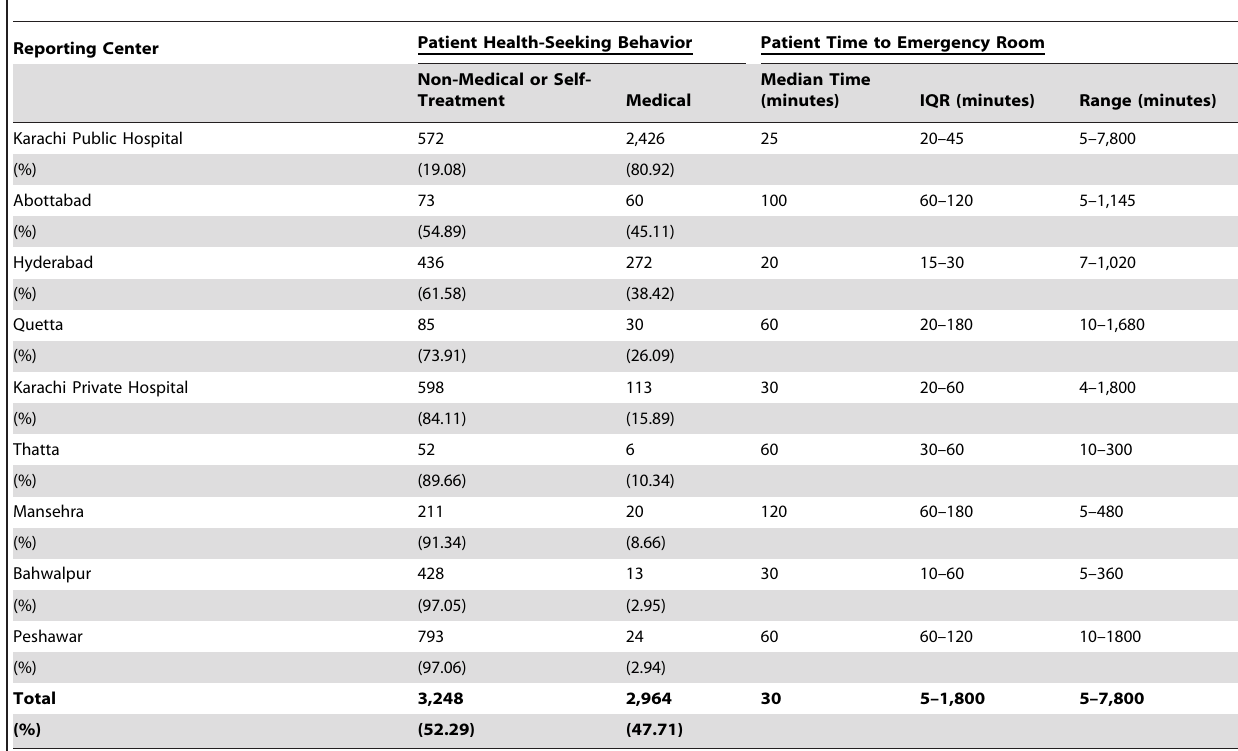
Table 2. Patient health-seeking behavior following dog-bites and travel time to emergency rooms in Pakistan (Feb 2009–Feb